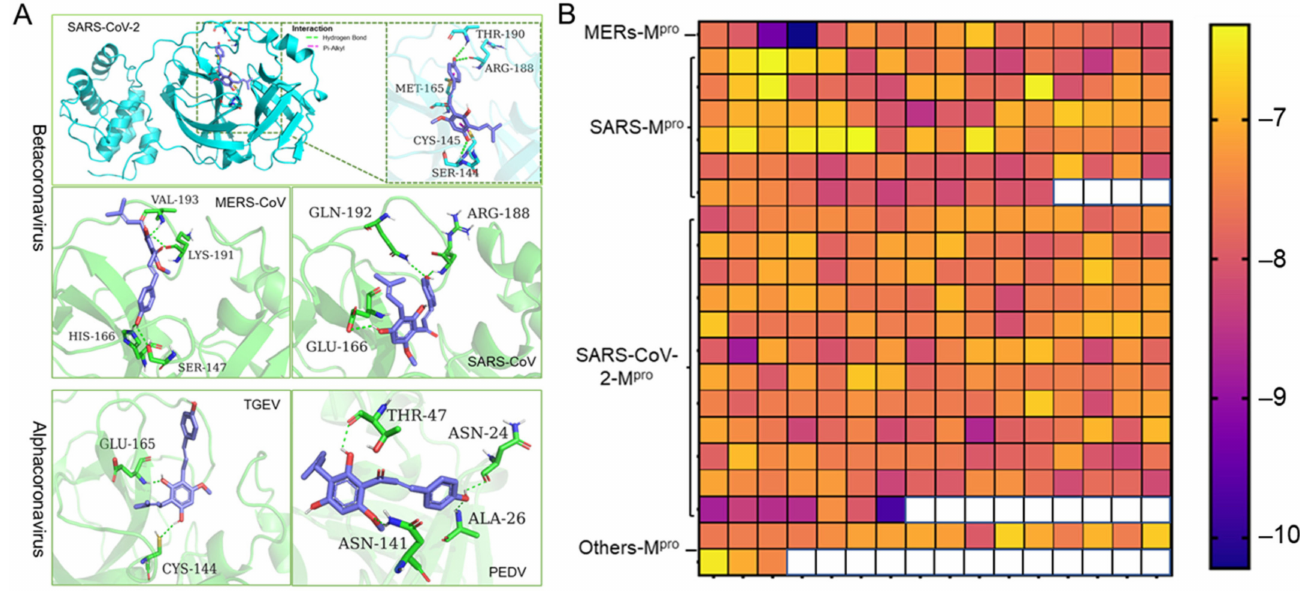
Figure 3. Xanthohumol is a potent pan-inhibitor of coronaviral M pro . ( A ) The interaction pattern between Xanthohumol and indicated M pro . The M pro was shown in cyan and green. The Xanthohumol was presented in purple. ( B ) The affinity diagrams between Xanthohumol and different M pro . M pro structures were downloaded from PDB, and the PDB ID and detailed docking scores are shown in Supplementary Data.